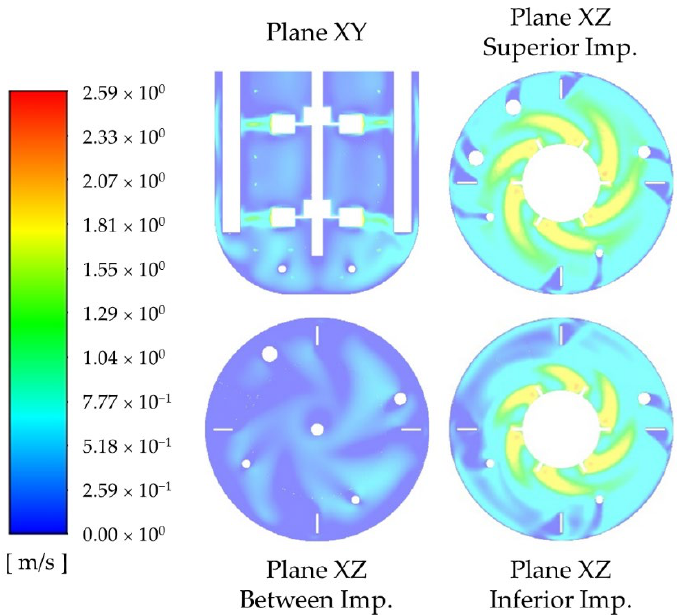
Figure A14. Contours of instantaneous velocity magnitude, computed after 58 impeller turns, for Xanthan Sol C.